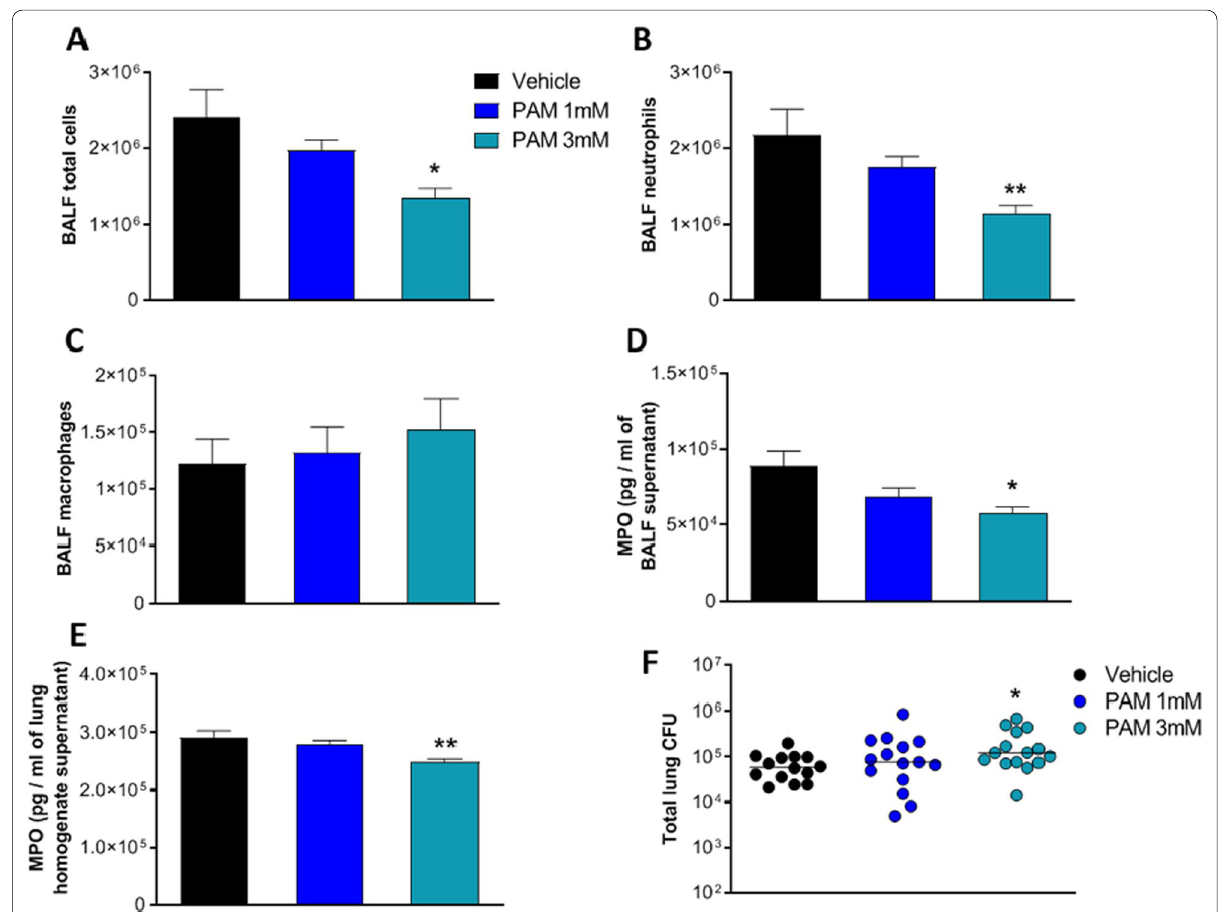
Fig. 3 Efficacy of aerosol treatment with PAM (1 mM and 3 mM) in a mouse model of acute P. aeruginosa airway infection. C57BL/6NCrlBR male mice (aged 8–10 weeks) received intratracheal inoculation with 1 10 6 CFUs of planktonic PAO1 strain. Five minutes after infection, PAM (1 mM, or × 3 mM or vehicle) were administered via an aerosolizer. After 6 h, mice were sacrificed, bronchoalveolar lavage fluid (BALF) was collected, and the lungs were excised and homogenized. Total cells ( A ), neutrophils ( B ) and macrophages ( C ) were counted on BALF. BALF and lung homogenates were centrifuged. MPO concentration was evaluated in the supernatants of BALF ( D ) and lung homogenate ( E ) by ELISA assay. Data are presented as mean SEM. BALF and lung homogenates were plated on tryptic soy agar to determine the bacterial burden ( F ). Each dot represents total CFUs ± per lung from one mouse, and horizontal lines represent the median values. Data are pooled from three independent experiments (n 14–15 = mice). Statistical significance is indicated: *P < 0.05; **P <